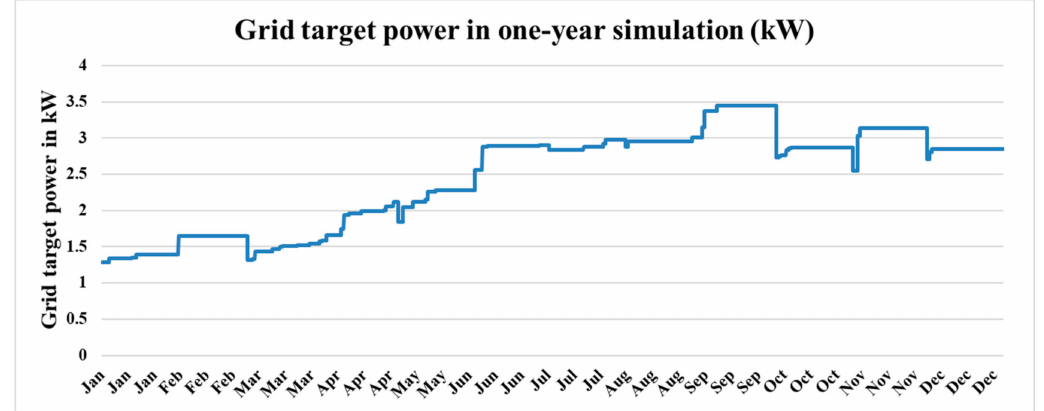
Figure 5. Example of grid target power in a one-year